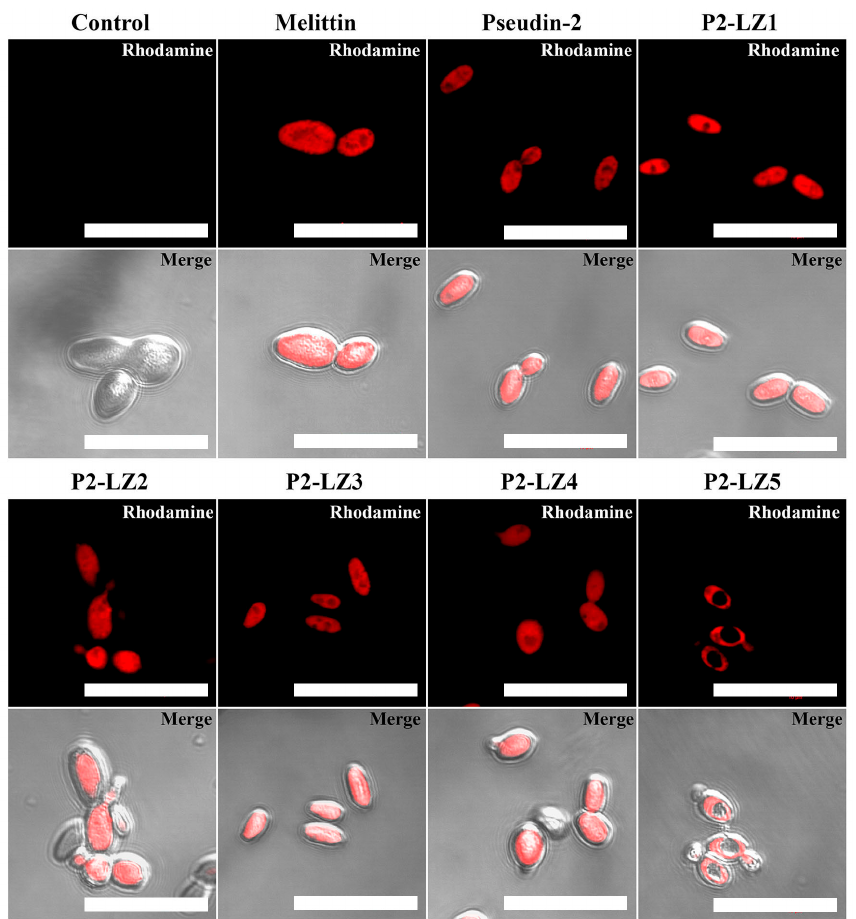
Figure 5. Cellular distributions of rhodamine-labeled pseudin-2 and P2-LZ peptides in C. tropicalis cells. Bar is 20 µm. Antibiotics 2020 , 9 , x FOR PEER REVIEW